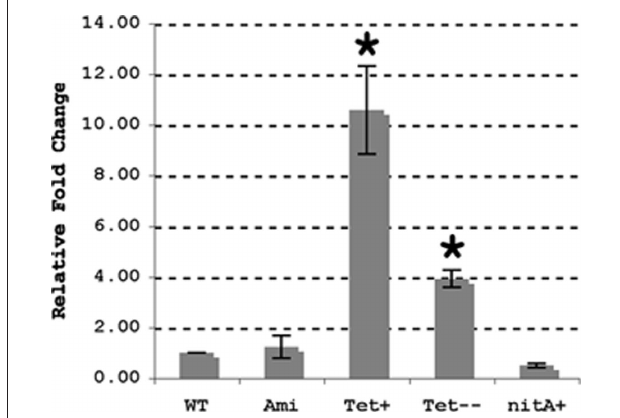
FiguRe 1 | expression of lys X in M. tuberculosis strains. Wild-type M. tuberculosis (WT) and the Pami (ami), Ptet (Tet), and Pnit A ( nit A) complement strains were used for RNA extraction. The Ptet complement was grown with (Tet + ) and without (Tet − ) tetracycline whereas the Pnit A strain was grown with isovaleronitrile. Expression of lys X was evaluated by real-time PCR using RNA isolated from each strain; these results were normalized against expression of 16s rRNA. lys X expression in the wild-type strain is assigned a value of 1 and all other results are shown as fold change relative to this value. All values are the means ± SD from two independent experiments with triplicate samples; single star represents P < 0.01 versus WT (Student’s t -test). Note lys X expression from Pnit A promoter was moderately less as compared to that in wild type ( P =